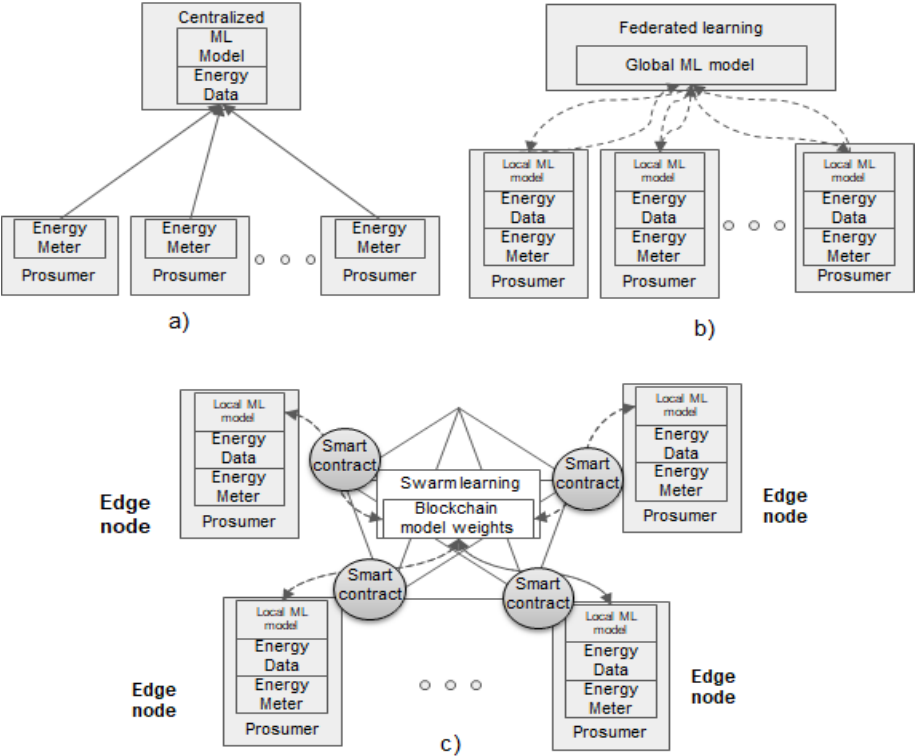
Figure 1. ML energy prediction models: ( a ) Centralized learning; ( b ) Federated learning (FL); ( c ) Swarm learning (blockchain-based distributed FL).